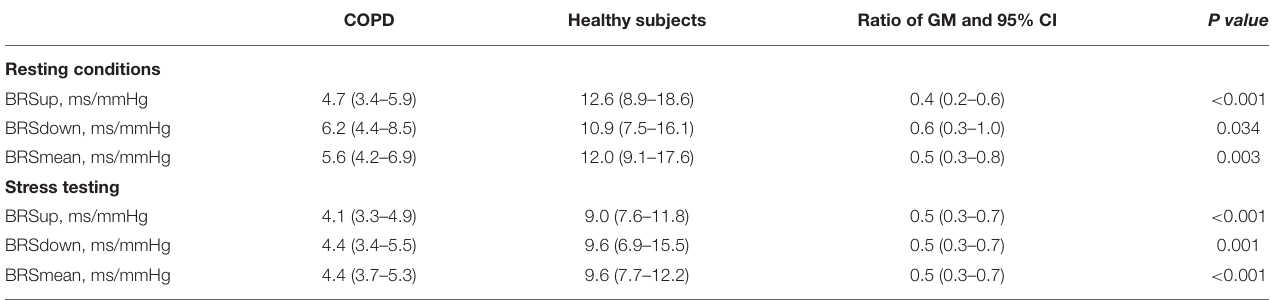
TABLE 3 | BRS slope values are indicated as geometric means with 95% CI. COPD Healthy subjects Ratio of GM and 95%